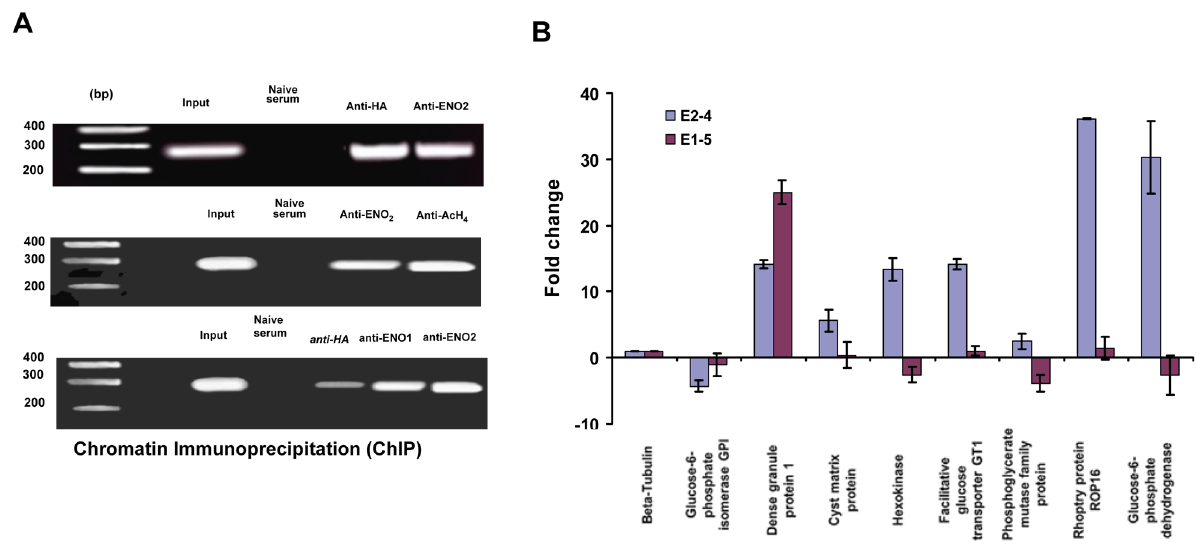
Figure 5. Nuclear enolases bind to promoters of several genes including their own and modulate transcriptional expression of several gene targets. A) The upper panel shows comparative chromatin immunoprecipitation (ChIP) from intracellular tachyzoites of a strain that ectopically overexpressed TgENO2-HA (E2-4) using polyclonal anti-HA and anti-ENO2 antibodies. No chromatin was immunoprecipitated with a non- relevant non-immune serum used as negative control. The middle panel shows chromatin immunoprecipitation (ChIP) of intracellular parasites that ectopically express TgENO2-HA (strain E2-4) with polyclonal antibodies specific to TgENO2 or acetyl histone H4, the epigenetic mark of an active promoter. The lower panel shows ChIP of parasites that ectopically express TgENO1-HA parasites (strain E1-5) with polyclonal antibodies specific to HA, TgENO1, and TgENO2. B) Changes in gene expression were confirmed by qRT-PCR analysis in the intracellular tachyzoites over-expressing TgENO2-HA and TgENO1-HA, compared with the beta-tubulin housekeeping gene and the expression of these genes in wild-type parasites. These experiments were repeated twice with triplicate samples and identical results were obtained n=3, (P , 0.001).